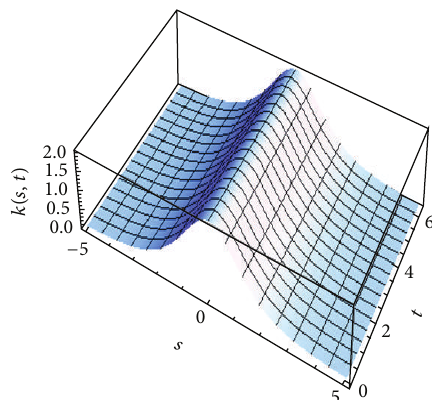
Figure 10: The surface that is generated by the motion of the family of curves 𝐶 𝑡 for 𝜏 0 = 0 , 𝑠 ∈ [0, 5] , 𝑡 ∈ [0,6.3] , 𝑐 1 = 1 , 𝑐 2 = 0 , and = 0 . The bold black curves in this surface represent the family of 𝑐 3 curves 𝐶 𝑡 for 𝑡 = 0, 1, 3,5 .